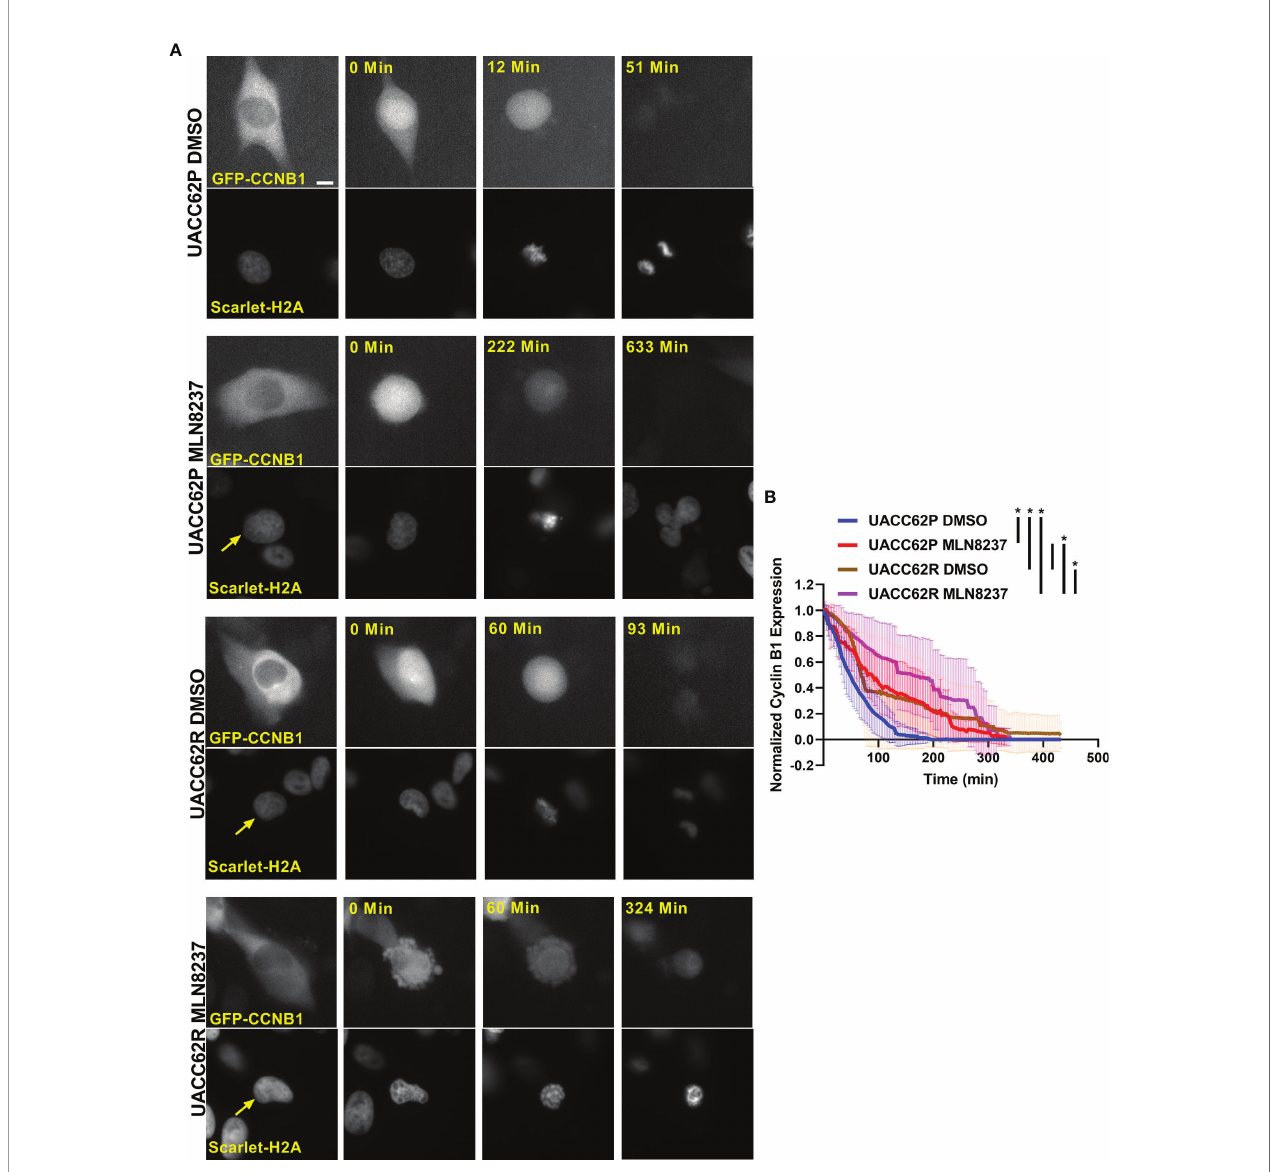
FIGURE 3 | Differential CyclinB1 degradation rates in UACC62P/R cells treated with AURKi. (A) Representative images of EGFP-CyclinB1 and mScarlet-H2A in DMSO or MLN8237-treated UACC62P/R cells. Scale bar = 10 µM. (B) Quanti fi cation of single cell kinetics of EGFP-CyclinB1 expression levels in DMSO or MLN8237-treated UACC62P/R cells was performed as described in Materials and Methods . The thick lines represent the mean EGFP-CyclinB1 expression across all cells, and the thin lines represent the standard deviation. At least 8 cells were analyzed per treatment condition. The area under each curve was calculated, and signi fi cant differences in curve areas were computed with a one-way ANOVA with a S ̌ ı ́ da ́ k ’ s multiple comparisons test. Statistical signi fi cance (p < 0.001) is indicated by an * near the corresponding fi gure